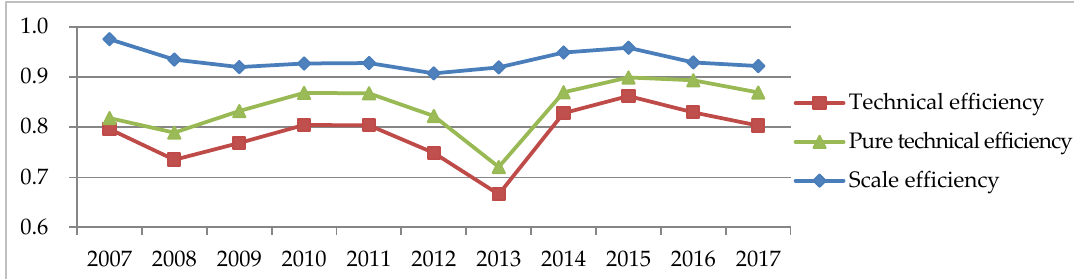
Figure 3. Change trend of TE (technical efficiency), PTE (pure technical efficiency) and SE (scale efficiency) values in China (2007–2017).